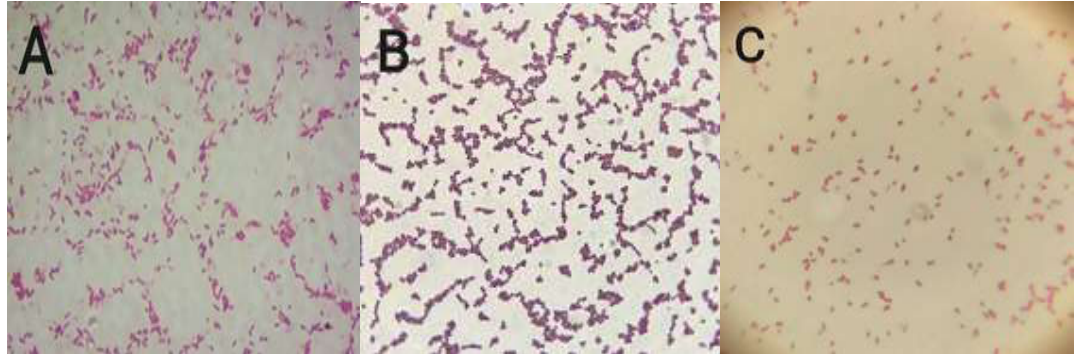
Figure 2: Show some microorganisms with gram stain (×100), (A) L.gasseri , (B) S.haemolyticus , (C) K.pneumoniae .